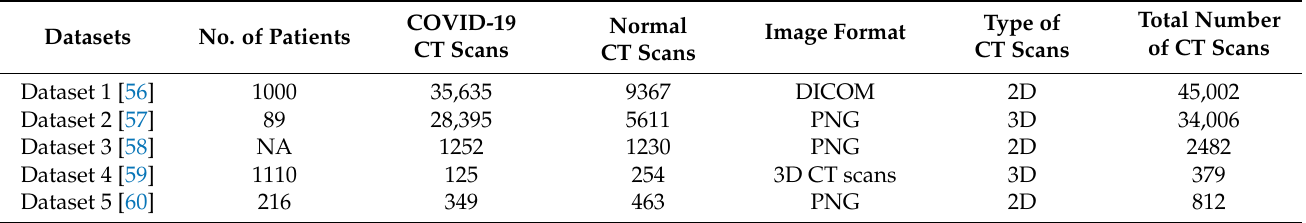
Table 2. Summary of the five datasets of CT scans of COVID-19 and normal